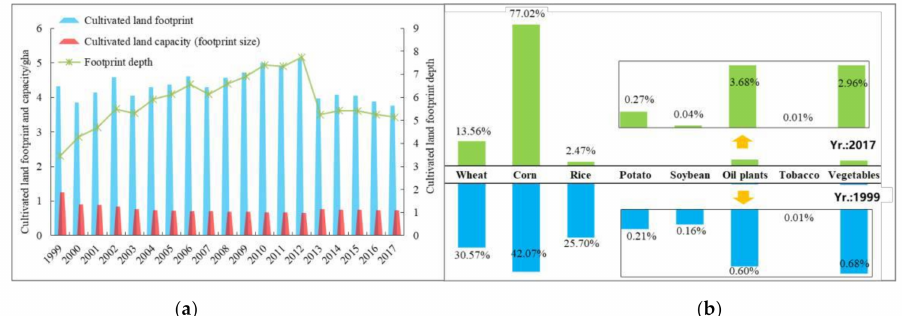
Figure 2. Changes in cultivated land’s natural capital use ( a ) and compositions of cultivated land footprint ( b ) in Ningxia from 1999 to 2017.